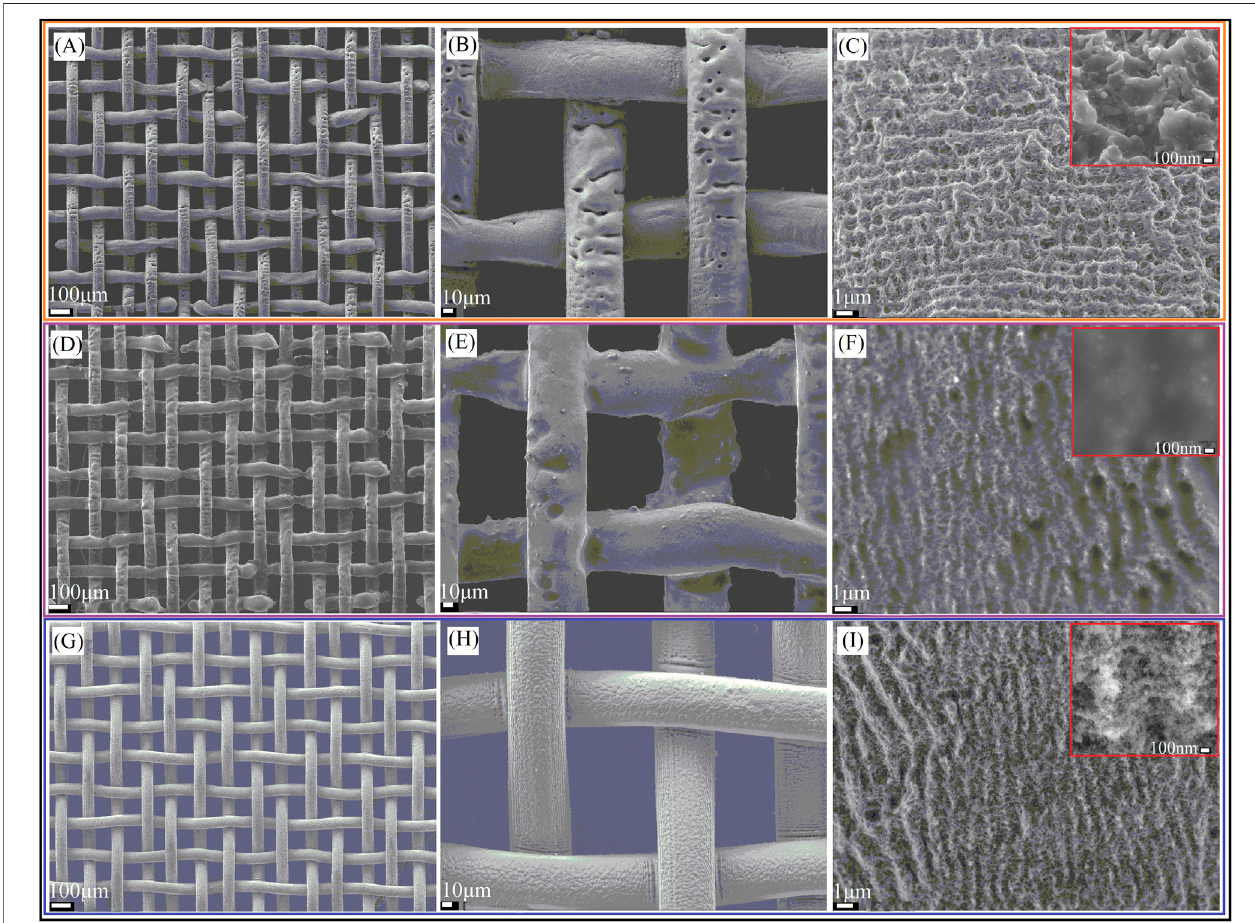
FIGURE 3 | SEM images for different treated sample. (A – C) After LT. (D – F) After LCT. (G – I) After LTCTO.